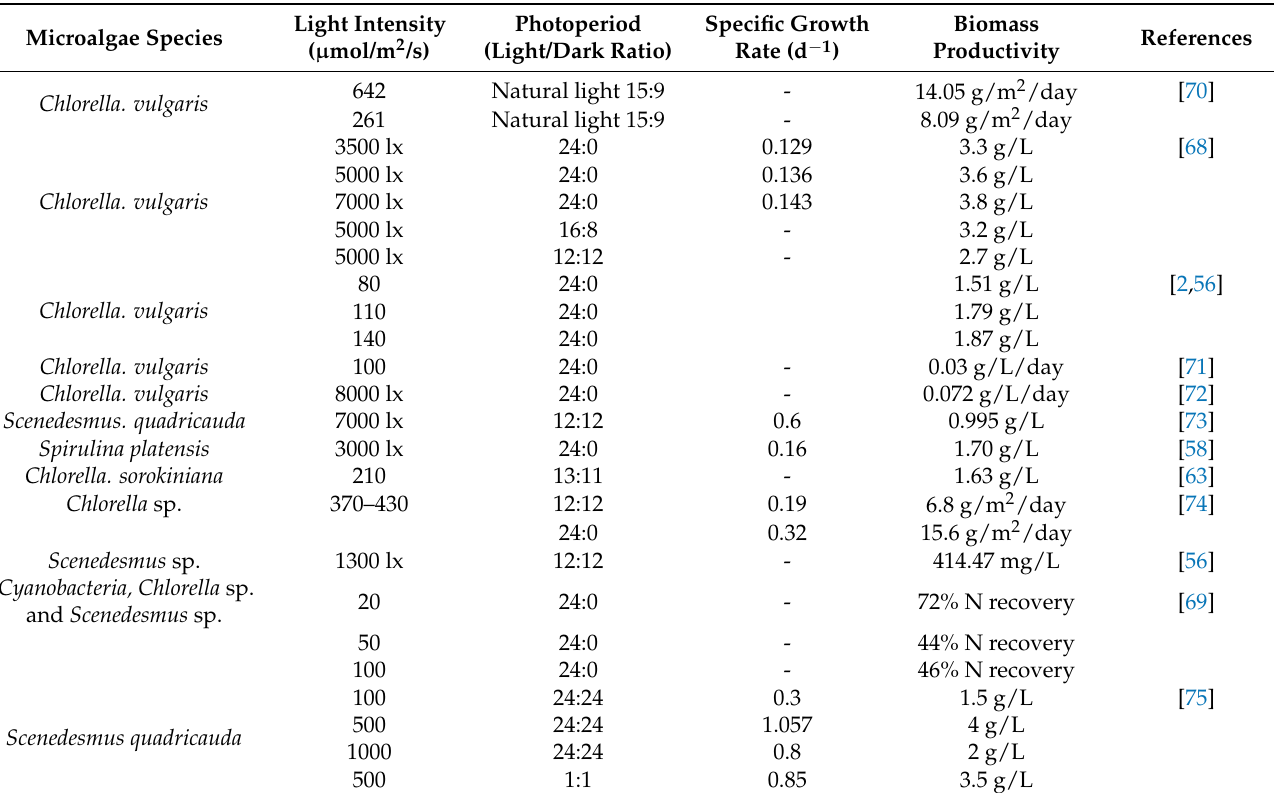
Table 3. Studies on the effect of light intensities and photoperiods on the performance of MA-based wastewater treatment